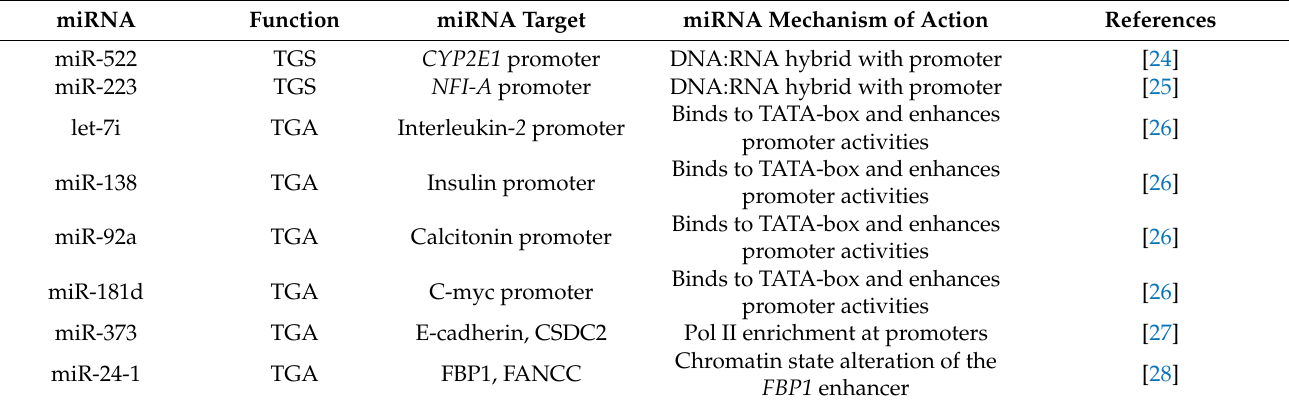
Table 1. Examples of miRNA-mediated transcription regulation in human